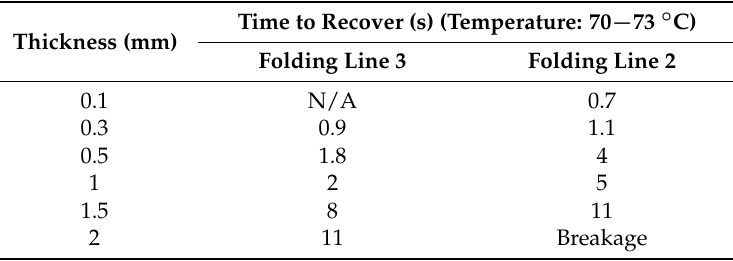
Table 6. Recovery time of folding line 3 and folding line 2.